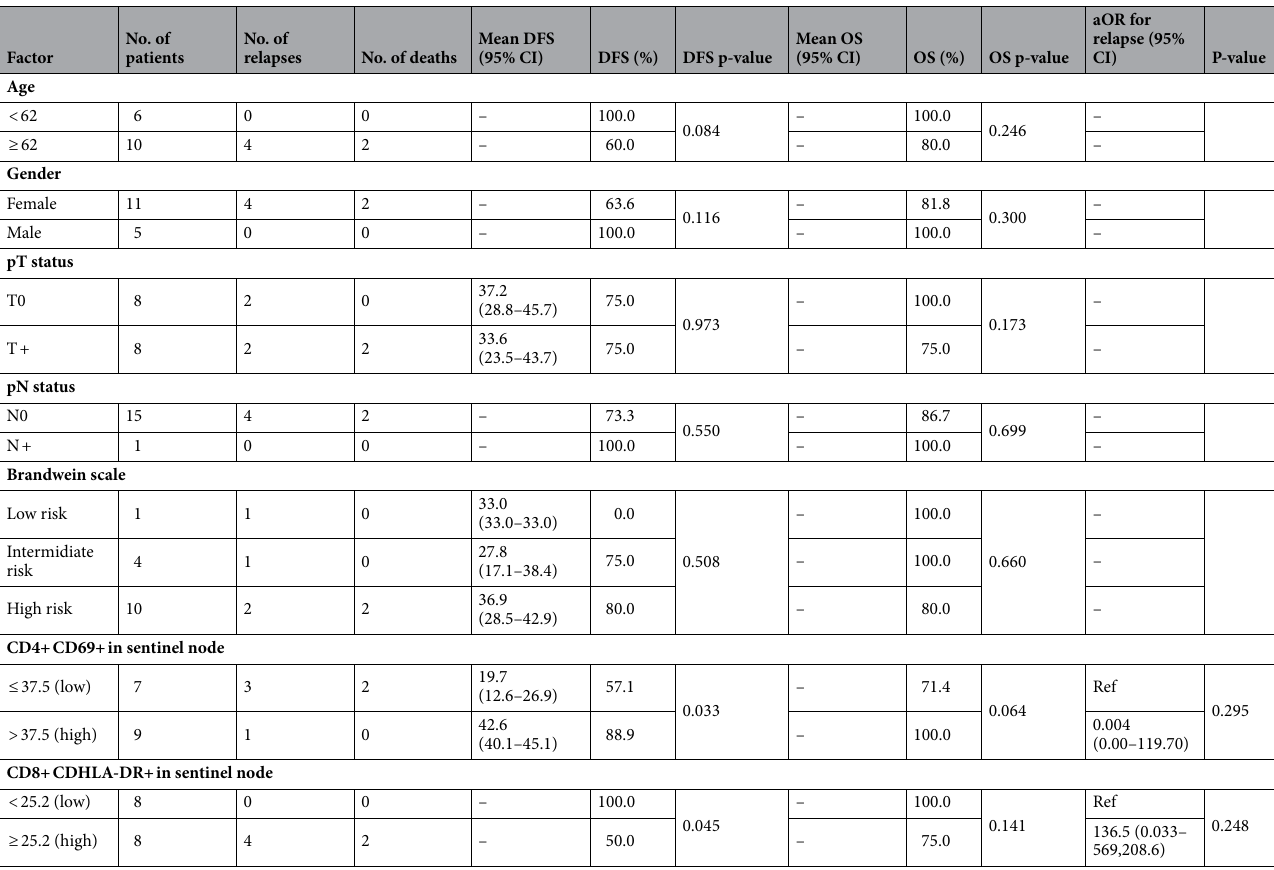
Table 2. Factors associated with DFS and OS in the studied population. Univariate analysis of DFS and OS with p value determined by log-rank test. Multivariate analysis by Cox proportional-hazards model for factors significant in univariate